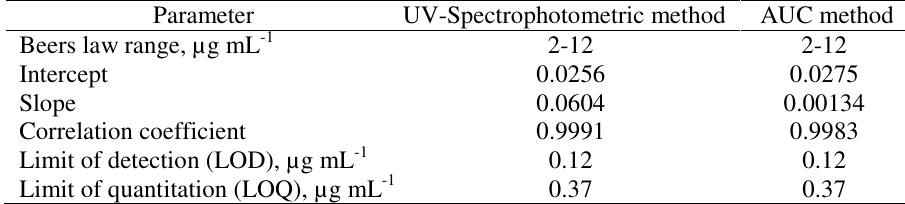
Table 1. Linearity of gemifloxacin mesylate.